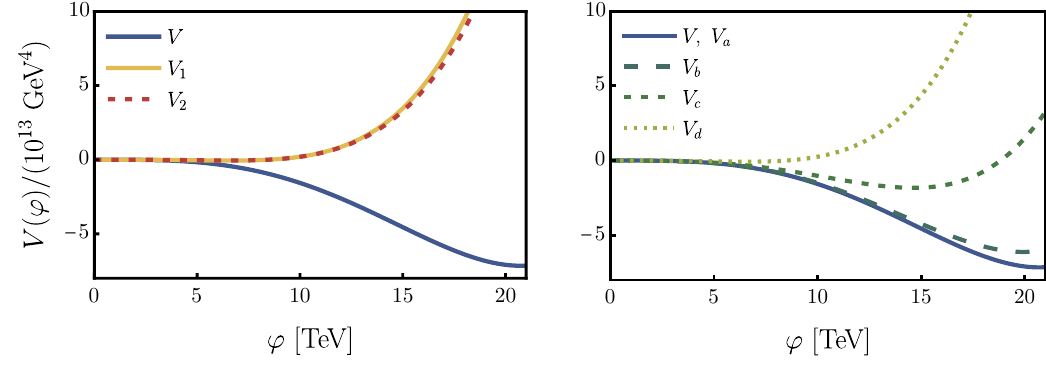
Figure 5 . Effective potential at zero temperature along the ϕ direction for a benchmark point with g X = 0 . 9 , M X = 10 4 GeV (defined at µ = M X ). Left panel: comparison of different approaches used in the literature, V of eq. (3.7) (yellow solid), V of eq. (3.8) (dashed red) and the full potential 1 2 V of eq. (3.6) used in this work (solid blue). Right panel: comparison of different approximations imposed on the full potential V of eq. (3.6) used in this work (solid blue) discussed in points (a)–(d) in the main text: V (long-dashed darkest green), V (medium-dashed dark green), V (short-dashed b c d light